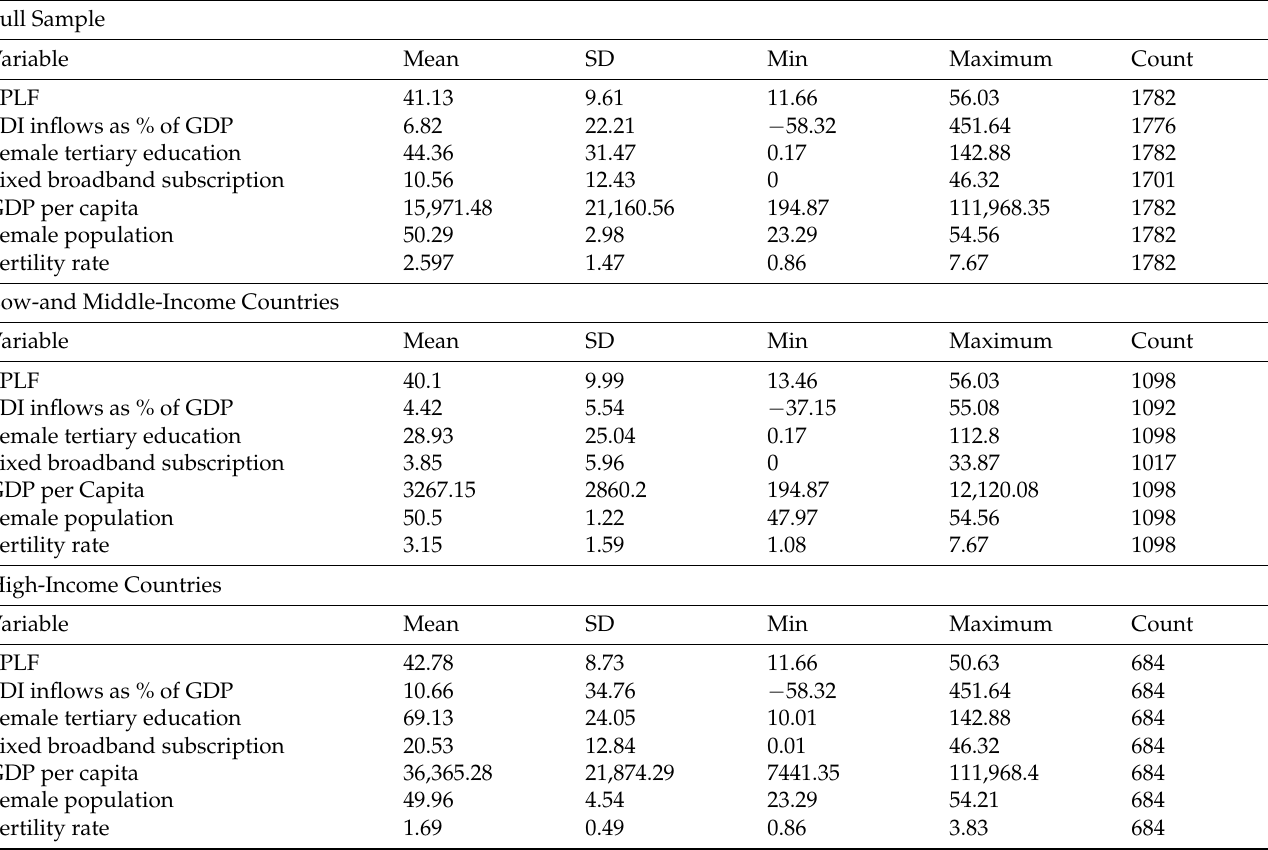
Table 1. Descriptive Statistics.